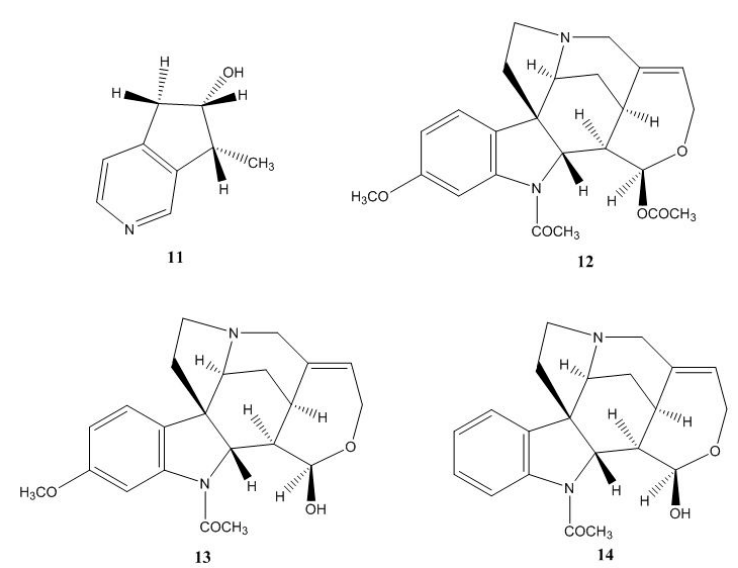
Figure 2. The isolated alkaloids ( 11 – 14 ) from the stem bark of Strychnos aff. darienensis .